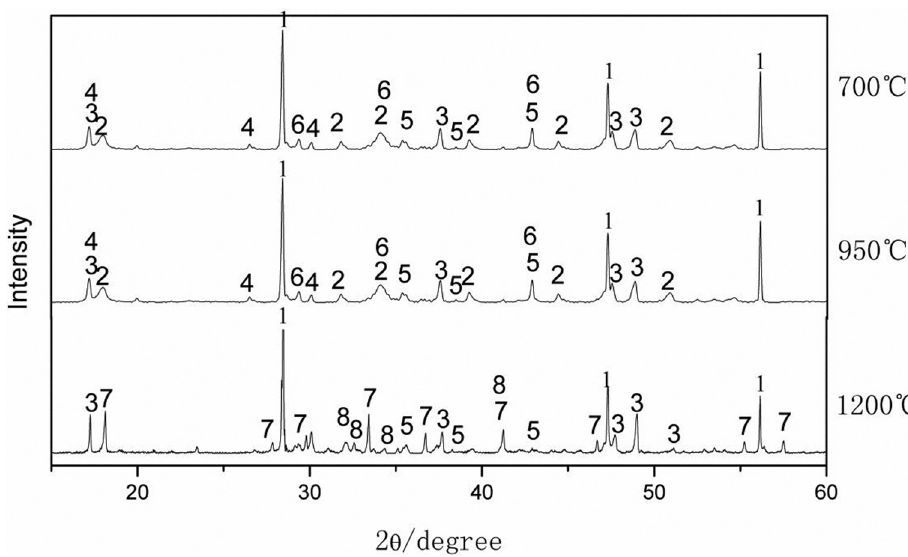
Figure 3: Slag phase at different temperatures.